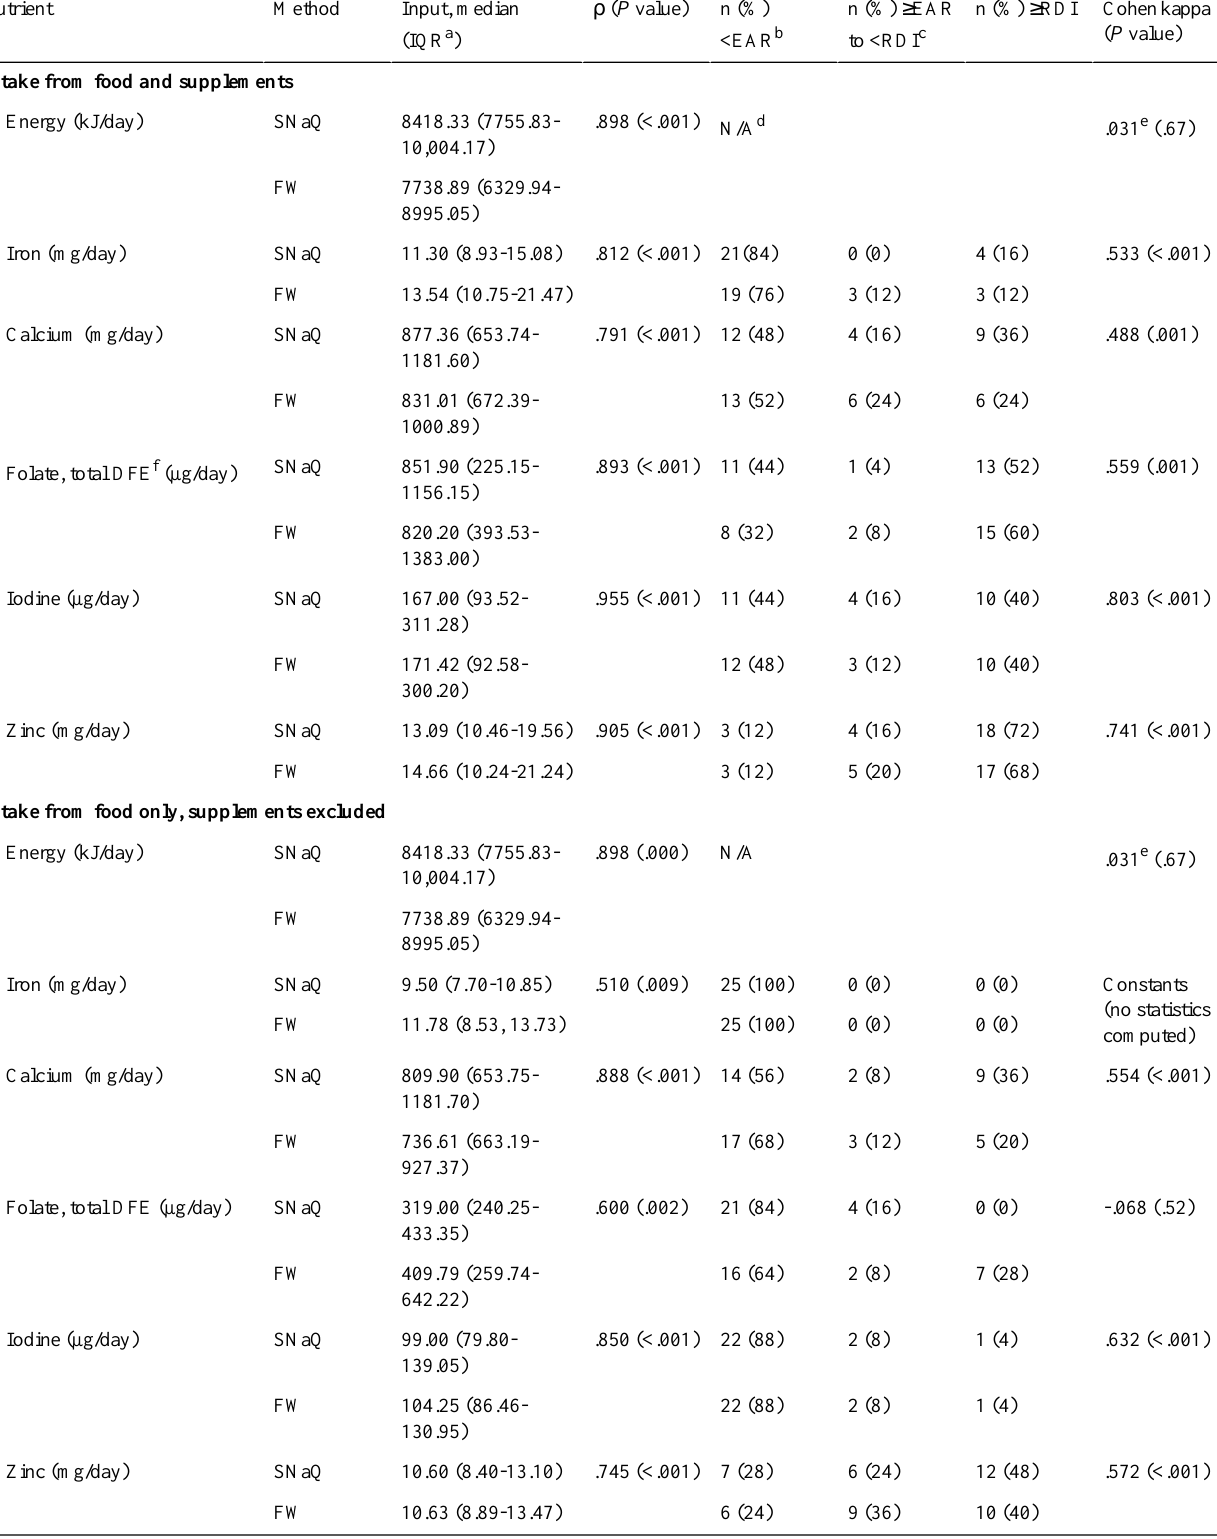
Table 2. Correlation and agreement for energy and selected nutrient intake from mean 3-day image-based dietary records in the Diet Bytes and Baby Bumps study (n=25 participants) analyzed by the Selected Nutrient and Diet Quality (SNaQ) tool and FoodWorks (FW) nutrient analysis